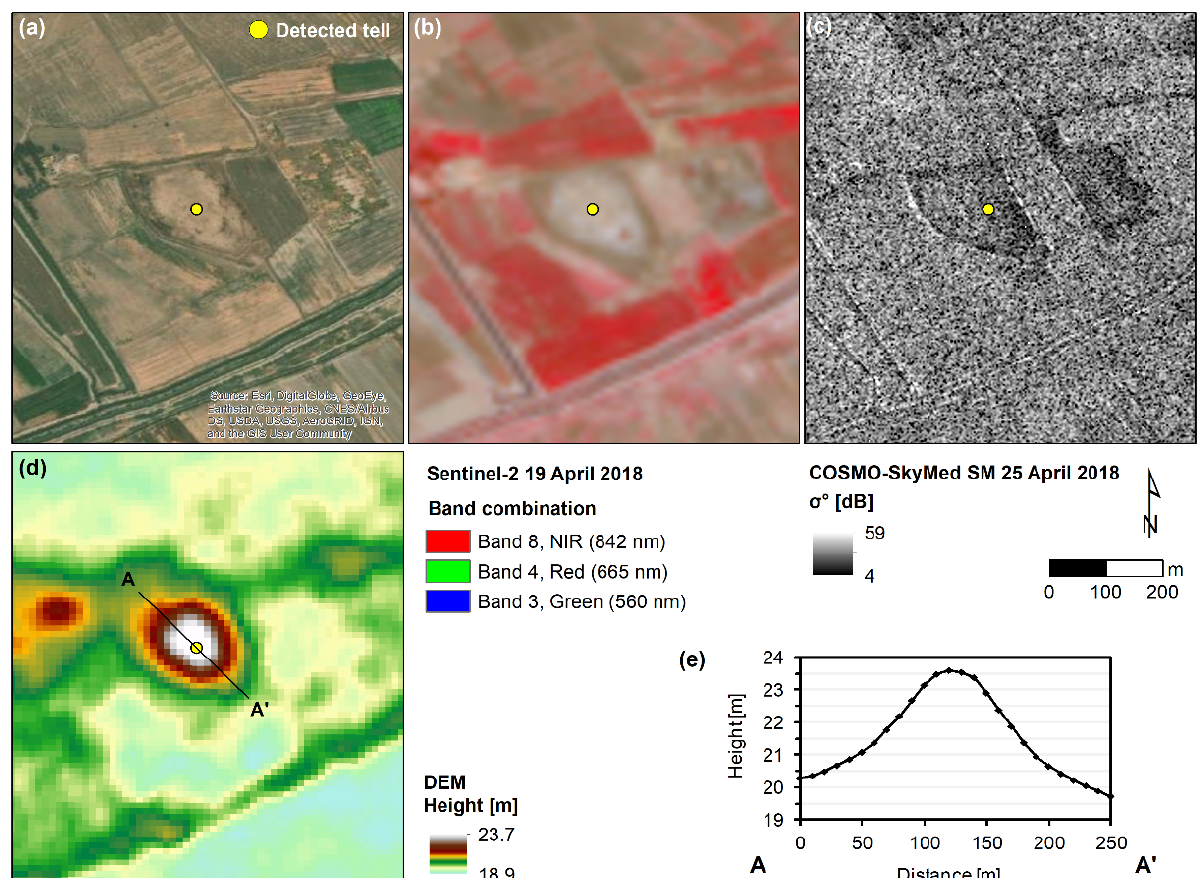
Figure 6. Tell detection through combination of ( a ) very high resolution (VHR) optical imagery, ( b ) Sentinel-2 multispectral false-colored composite (R: Band 8—NIR; G: Band 4—red; B: Band 3—green), COSMO-SkyMed ( c ) SAR radar backscatter image, and ( d ) DEM with ( e ) height profile drawn along A-A’ section. Products in ( b – d ) were all collected in April 2018. Example of clear visibility of a single mound with mud-brick architecture (precise location undisclosed for security concerns). COSMO-SkyMed ® Products ©ASI, Italian Space Agency, 2018. All rights reserved. Contains Copernicus Sentinel-2 data, 2018.